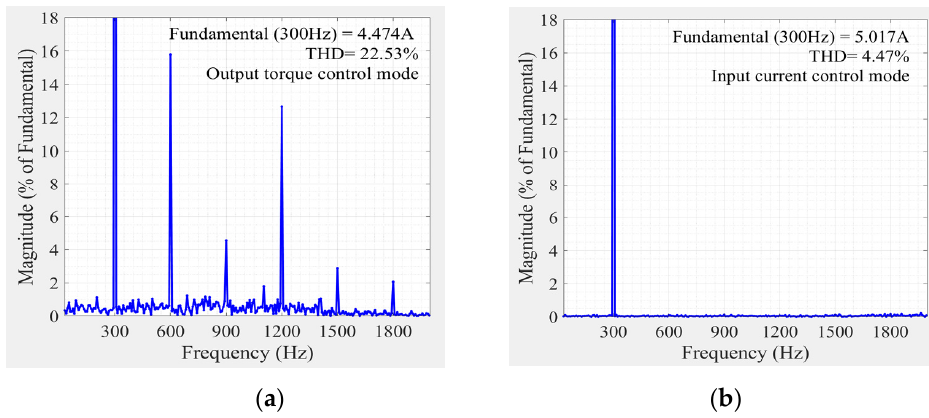
Figure 12. FFT of the PEMFC current : ( a ) Under the conventional phase current control; ( b ) Under the proposed input current control.